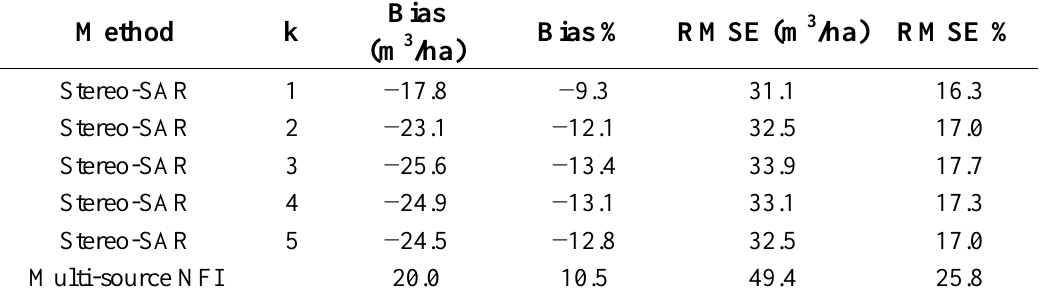
Table 5. Stand-level estimation accuracy of forest volume by stereo-SAR and multi-source NFI.